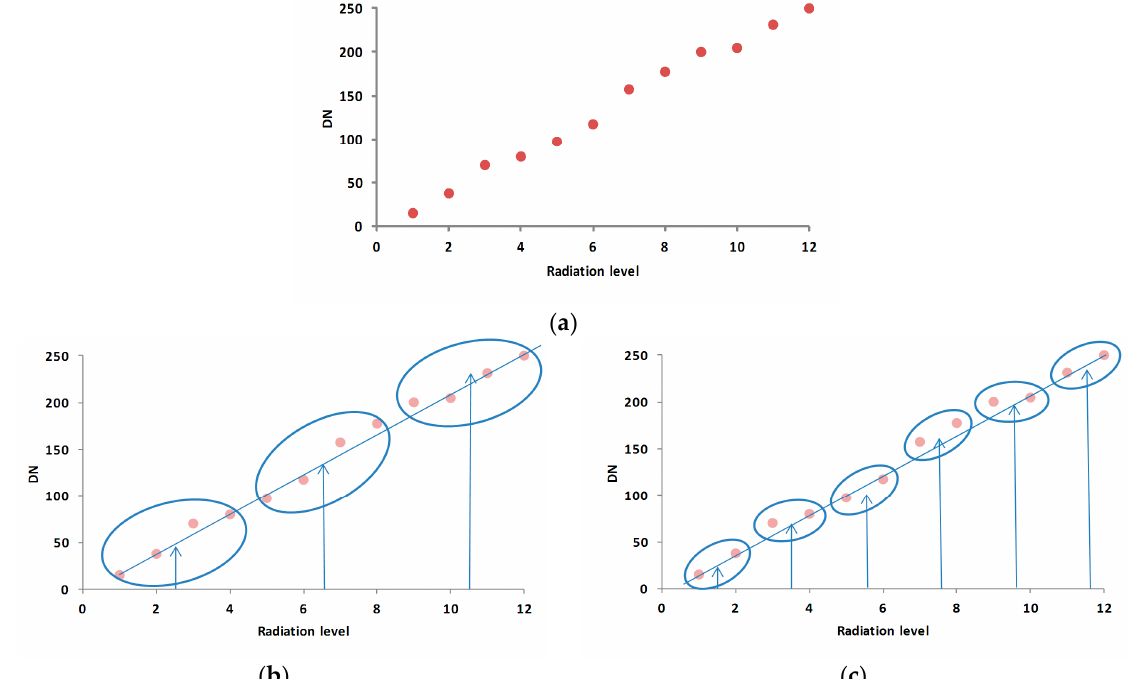
Figure 1. The schematic of grouping and its effect on fitting results. ( a ) scatter plot of pixel data; ( b ) data was divided into three groups; ( c ) data was divided into 6 groups. The horizontal axis and vertical axis are the radiation level and digital number (DN), respectively. The ellipses, arrows and oblique lines in ( b , c ) are grouping area, average results of each group and fitting results, respectively.